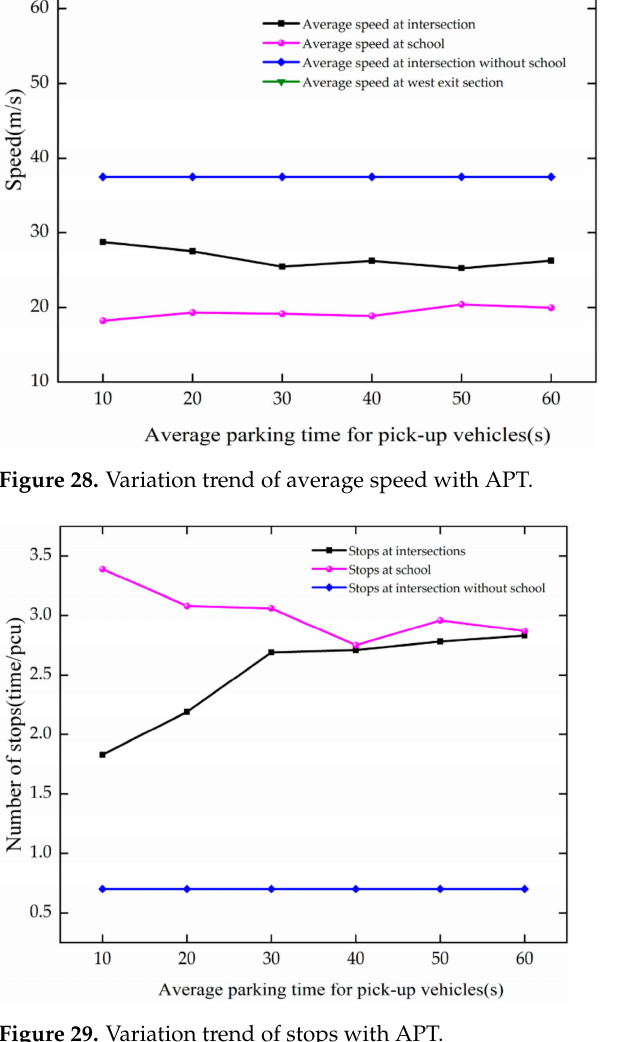
Figure 29. Variation trend of stops with APT.